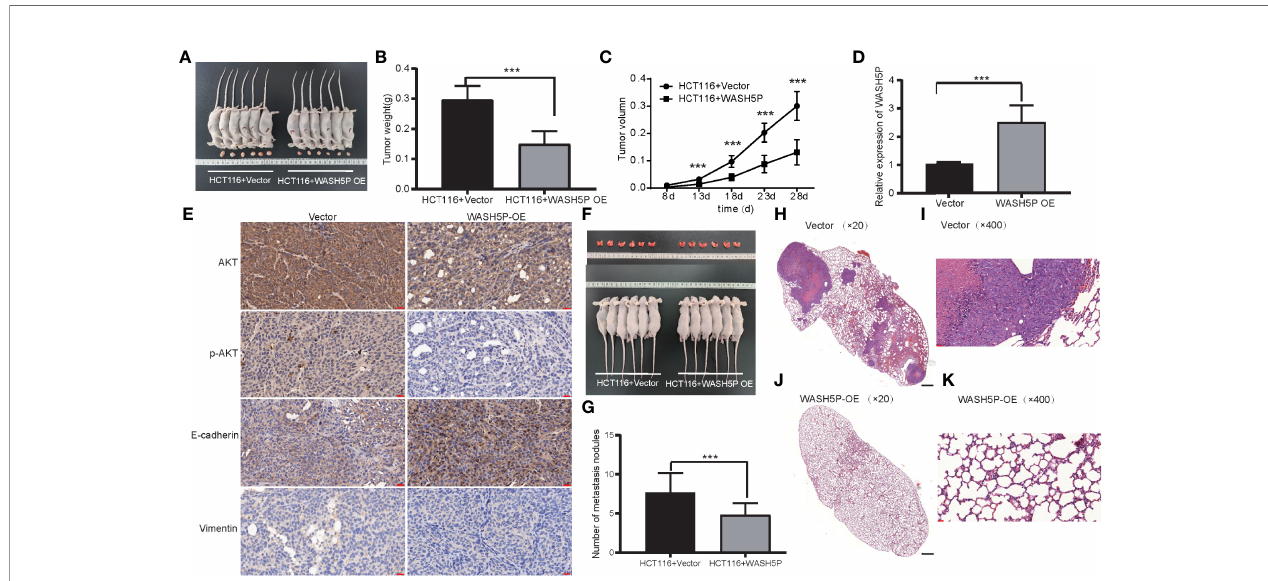
FIGURE 4 | LncRNA WASH5P signi fi cantly inhibits CRC in vivo . (A) Mice carrying xenograft tumors treated with lncRNA WASH5P (n=6, right panel) or vector (n=6, left panel) at the last time point. (B) The xenograft tumors were separated and weighted at the end of the experiments. ***. Correlation is signi fi cant at the 0.001 level. (C) Tumor volume was measured in lncRNA WASH5P or vector groups. Data represent the mean with a 95% con fi dence interval. ***. Correlation is signi fi cant at the 0.001 level. (D) Expression level of WASH5P was con fi rmed by real-time PCR in the xenograft tumors of the WASH5P-overexpressed group and vector group. ***. Correlation is signi fi cant at the 0.001 level. (E) Immunohistochemical analysis revealed the expression of AKT, pAKT, epithelial (E-cadherin), and mesenchymal (vimentin) markers in the tumors of different groups. Original magni fi cation: ×200. Scale bars represent 20 µm. (F) Pulmonary images of mice in a metastatic mouse model treated with vector (n=6, left panel) or lncRNA WASH5P (n=6, right panel) at the last time point. (G) Summarized data of tumor lung nodules in nude mice at 45 days in lncRNA WASH5P or vector groups; n = 6. ***. Correlation is signi fi cant at the 0.001 level. (H – K) Representative H&E images of the lungs of nude mice metastasis at 45 days in two groups: vector group (H, I) and WASH5P-overexpressed group (J, K) . The black scale bars in H and J represent 500 µm. The red scale bars in I and K represent 20